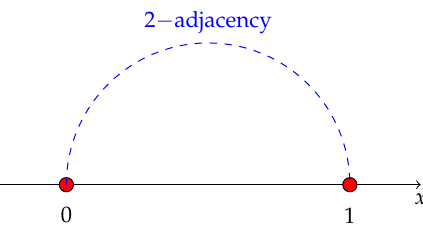
Figure 1. A digital image X with the 2-adjacency relation along with the dotted curve.